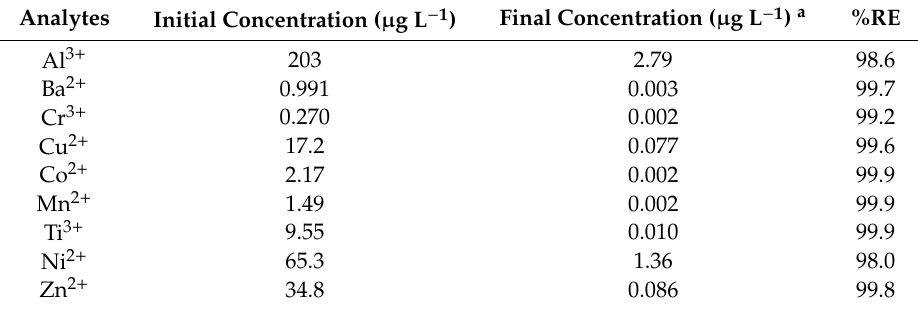
Table 6. Application of Fe 2 O 3 -SiO 2 -PAN nanocomposite for removal of trace elements in real sample (n = 6 replicates).